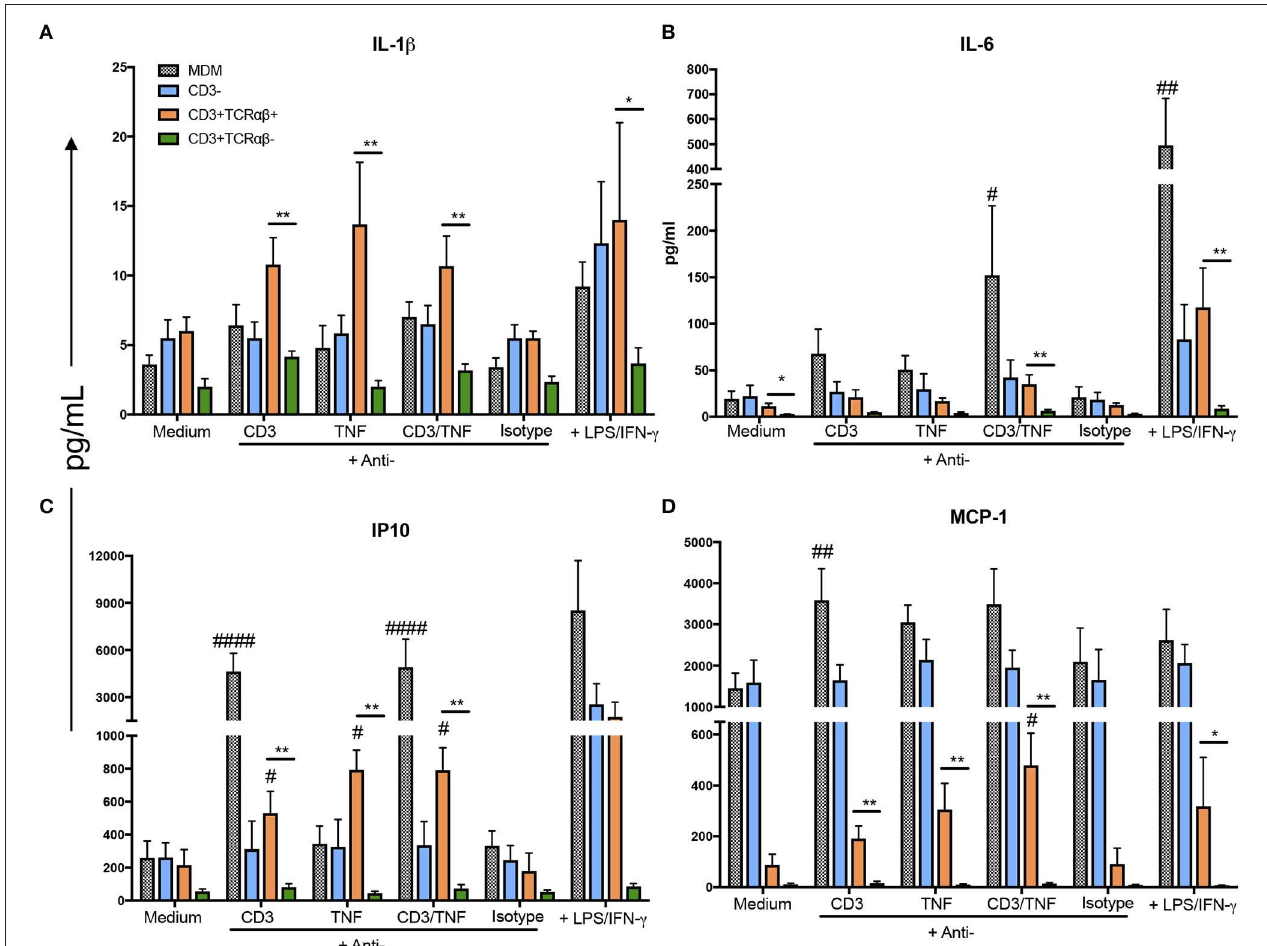
FIGURE 7 | CD3 + TCR αβ + MDM secrete IL-1 β , IP-10, and MCP-1 by CD3- and TNF-dependent pathways. The supernatant of MDM subpopulations was recovered after 24h in culture from unstimulated or stimulated by anti-CD3 or anti-TNF antibodies or anti-CD3 plus anti-TNF, isotype control and LPS plus IFN- γ , to perform a multiplex analysis. Pro-inflammatory cytokines IL-1 β and IL-6 ( A,B , respectively) and pro-inflammatory chemokines IP-10 and MCP-1 ( C,D , respectively) were evaluated using Luminex technology. The data are expressed as the mean ± SD of n = 4–6 independent donors per condition. A statistical analysis was performed by multiple Bonferroni-Dunn comparisons. * p < 0.05, # p < 0.05, ** p < 0.01, ## p < 0.01 and #### p < 0.0001 (*Indicates difference between groups, # indicates the difference compared with its negative control